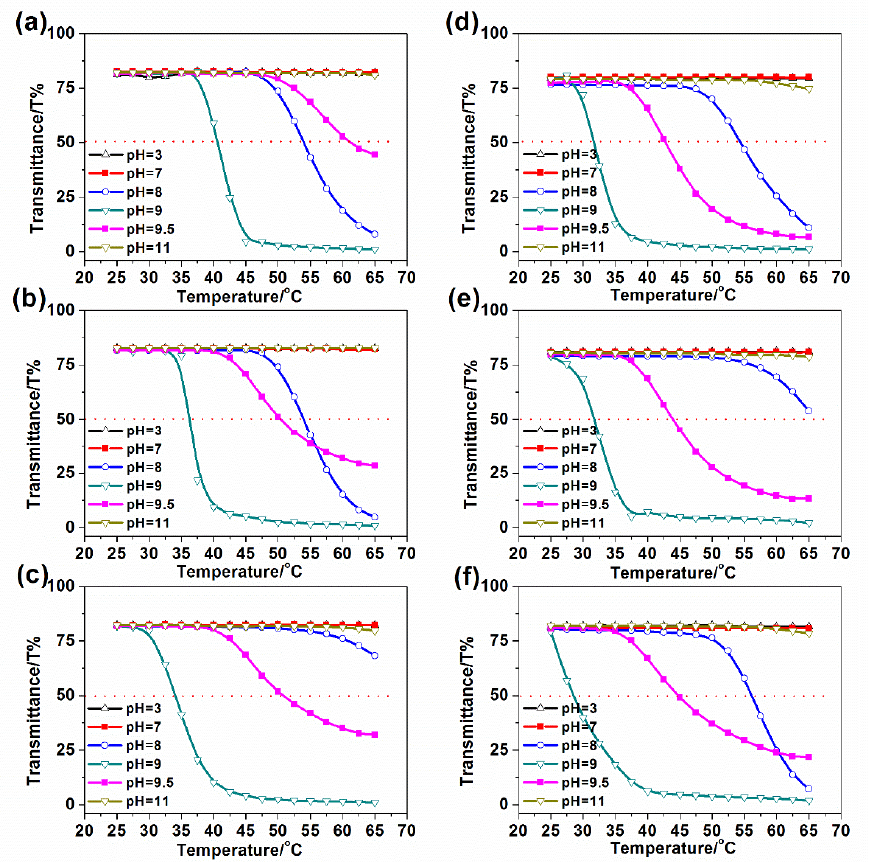
Figure 4. The Effect of the pH value of 1.0 mg mL − 1 aqueous solutions of 4-arm star-PAA 1 - b - PDMAEMA 4 ( a ), 8-arm star-PAA 1 - b -PDMAEMA 4 ( b ), 12-arm star-PAA 1 - b -PDMAEMA 4 ( c ), 4-arm star-PDMAEMA 4 - b -PAA 1 ( d ), 8-arm star-PDMAEMA 4 - b -PAA 1 ( e ), 12-arm star-PDMAEMA 4 - b -PAA 1 ( f ) on the LCST and temperature curve when the transmittance of the solution was monitored at 500 nm at a heating rate of 0.5 °C min − 1 .